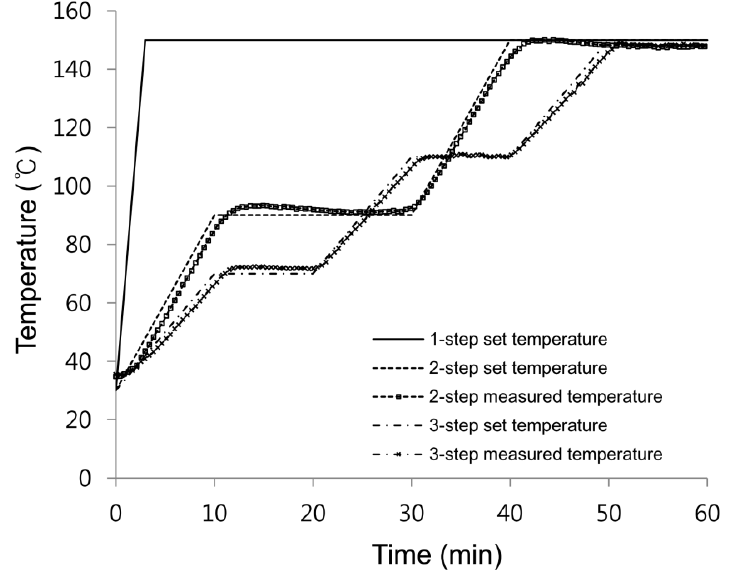
Figure 2. Temperature-time cure cycle